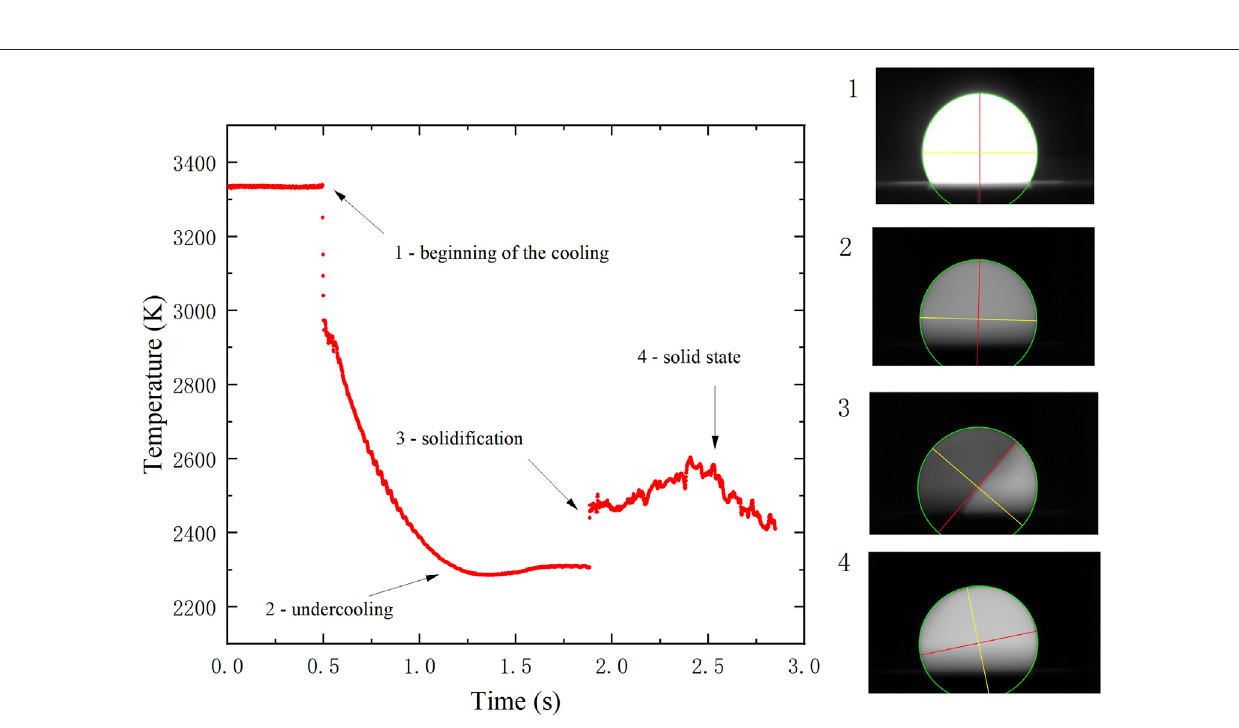
Frontiers in Energy Research |